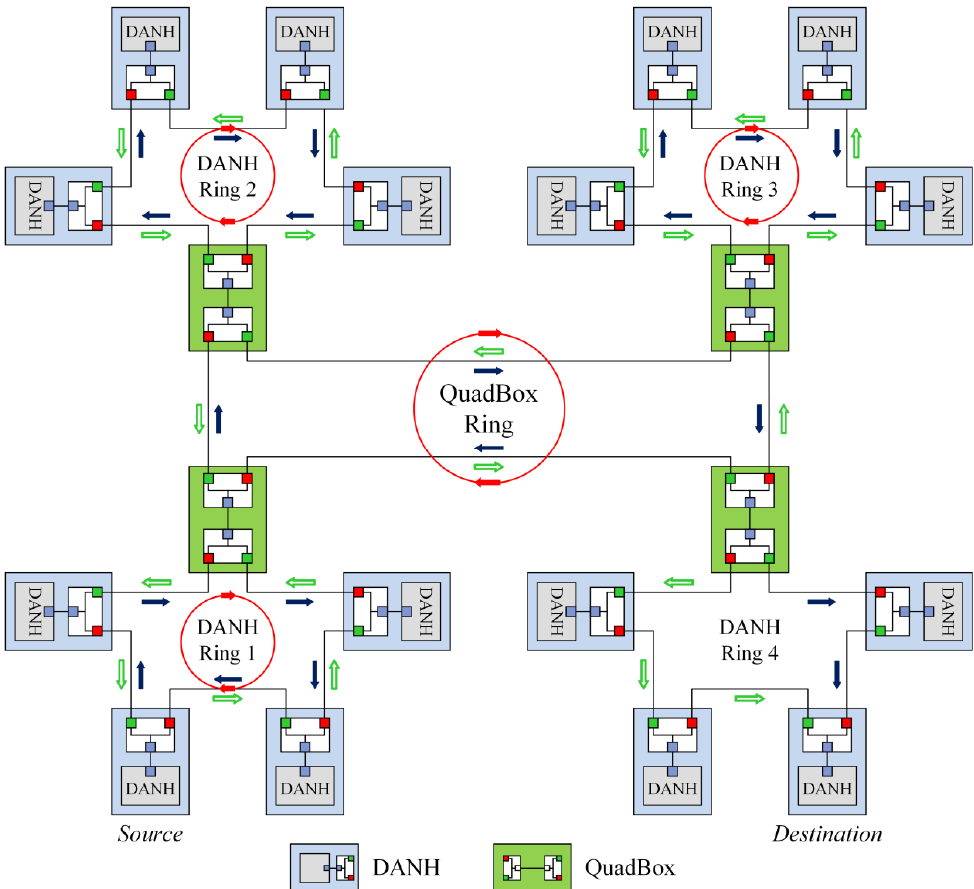
Figure 2. HSR example of connected-ring topology for unicast